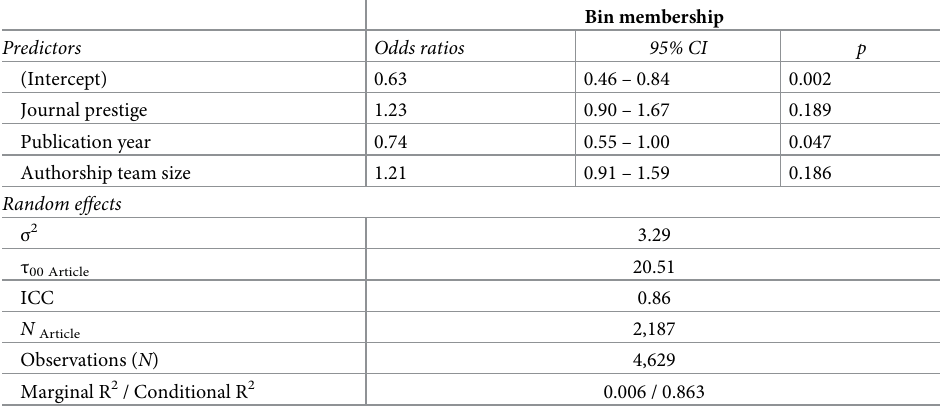
Table 9. Multilevel logit regression results for predictors of bin membership (non-substantive